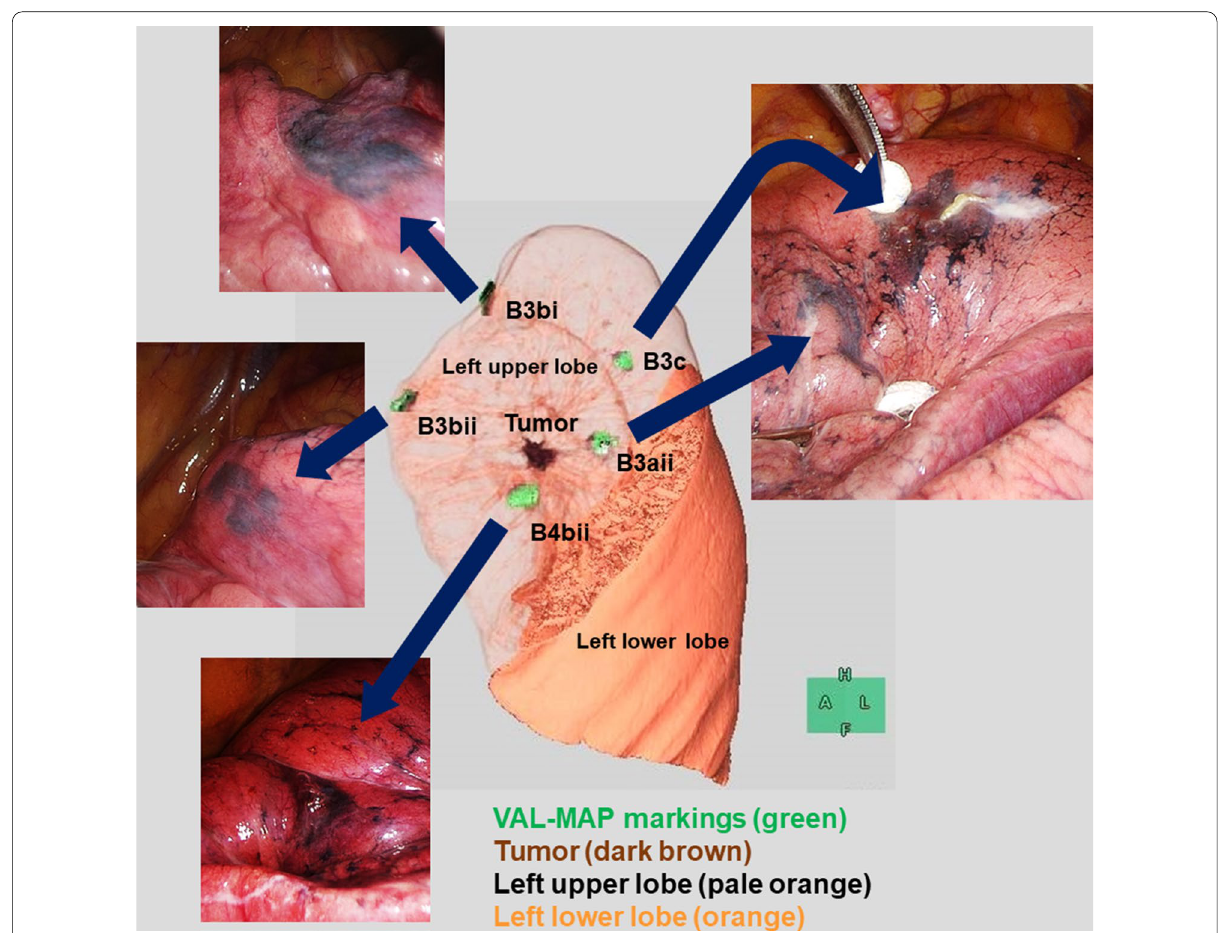
Fig. 2 Post-mapping three-dimensional image (center) and photographs (arrows) of the mapping. Dye markings are apparent in the peripheral branches of B3aii, B3bi, B3bii, B3c, and B4bii (green). Among them, two markings (B3c and B4bii) were complicated with bulla formation. The tumor is shown in dark brown, the left upper lobe in pale orange, and the left lower lobe in